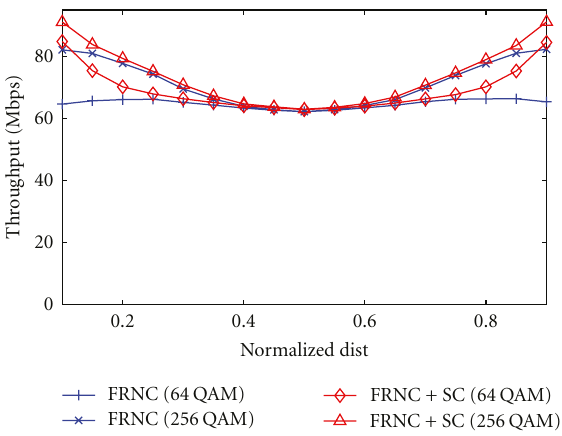
Figure 9: Throughput achieved by di ff erent schemes on the broadcast channel-e ff ect of relay position for two way